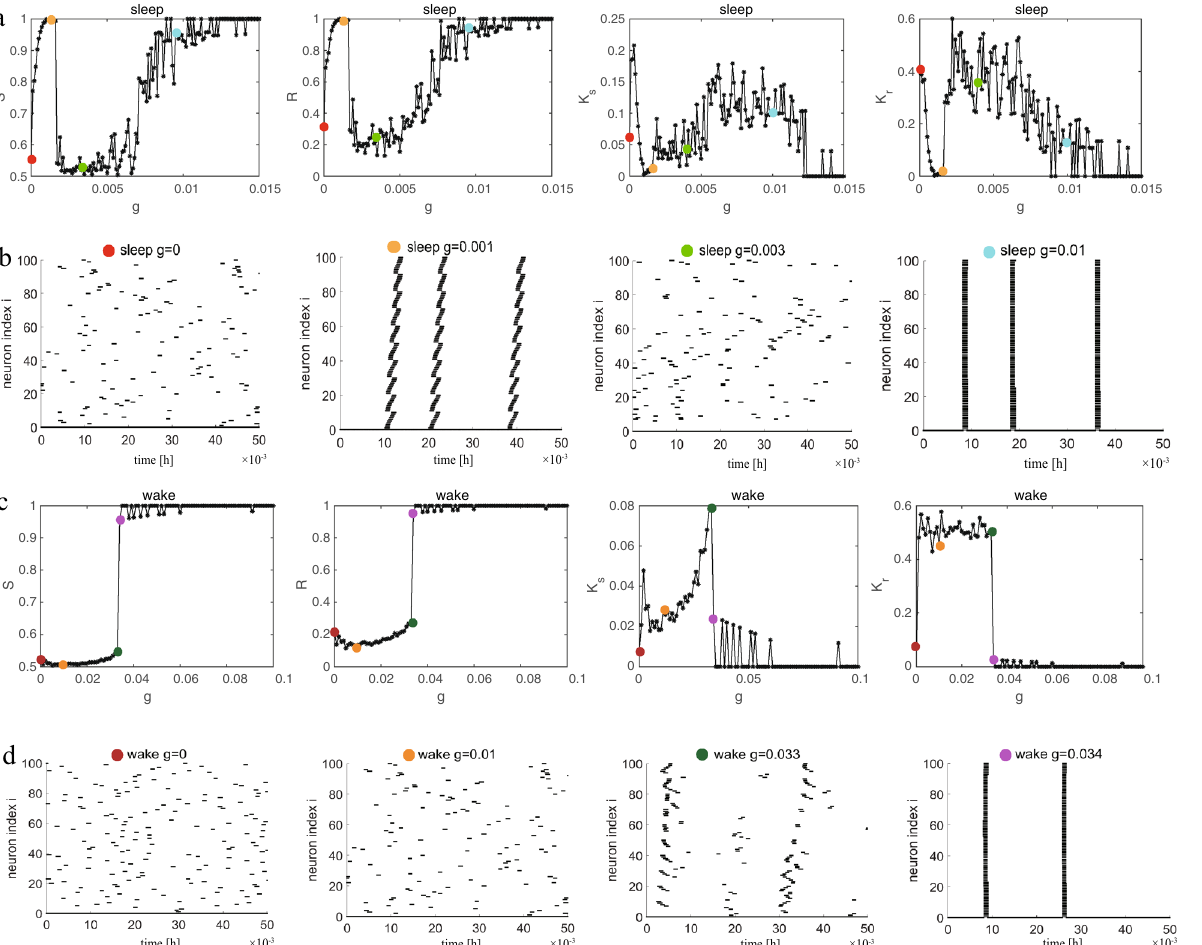
Figure 1. Synchronization diagrams of the coupled neurons in lattice network with ( k = 4 ) during sleep and wake. ( a ) The global order parameter S , R and the corresponding susceptibility κ S , κ r during sleep. ( b ) Raster plots corresponds to four specially colored points in ( a ). ( c ) The global order parameter S , R and the corresponding susceptibility κ S , κ r during wake. ( d ) Raster plots corresponds to four specially colored points in ( c